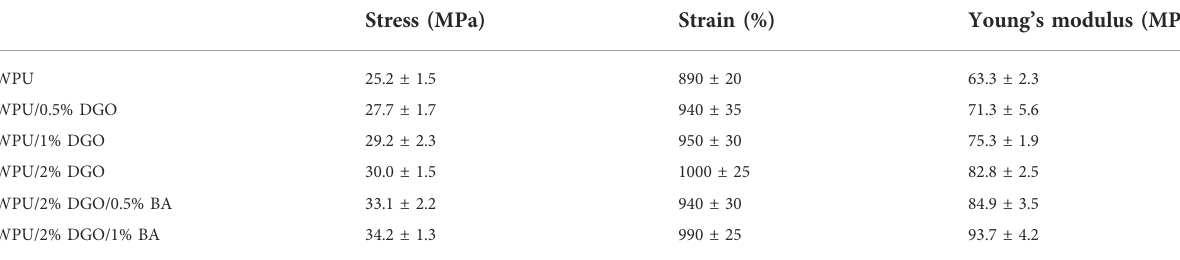
TABLE 1 Mechanical properties of WPU and its composite.